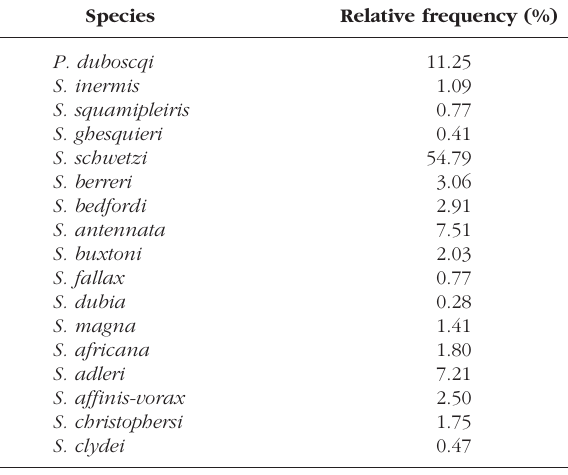
Table I. – List and percentage of different species of phlebotomine sandflies trappings (yearly longitudinal and intensive collections at the end of the rainy and dry seasons) from October 2005 to Sep- tember